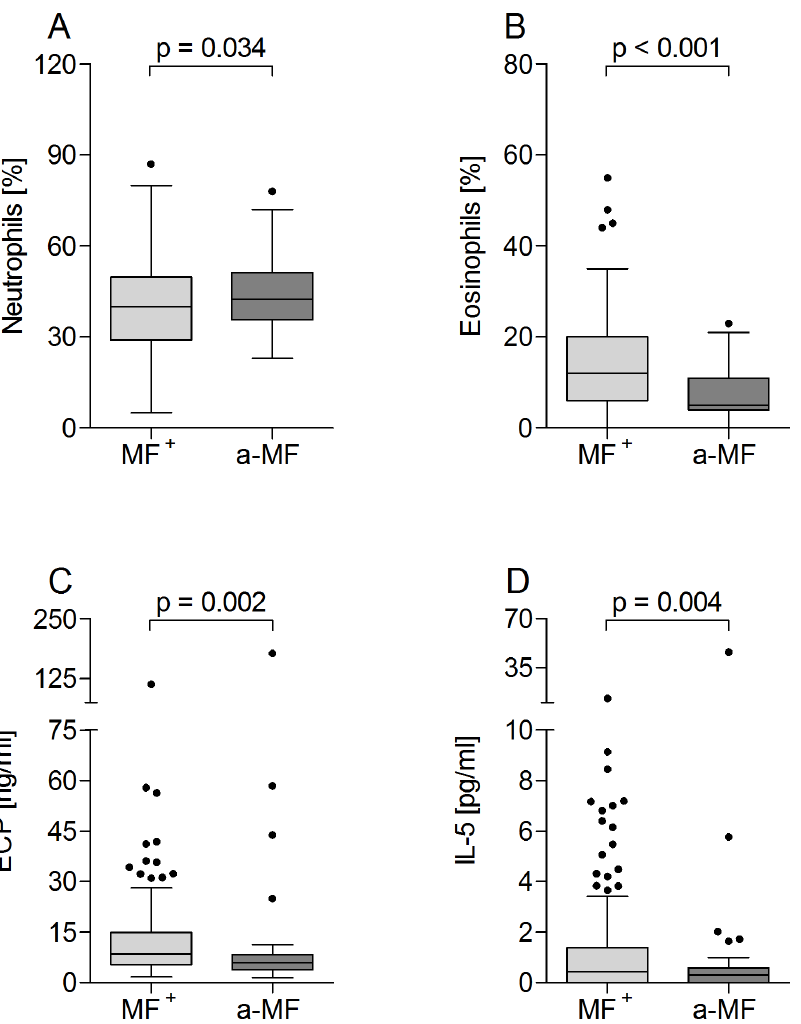
Figure 3. Decreased levels of eosinophils and eosinophil-associated proteins in a-MF patients. O. volvulus infected participants were investigated for the percentages of neutrophils (A) and eosinophils (B) using standard Giemsa stained blood smears. In addition, the presence of ECP (C) and IL-5 (D) were determined in plasma samples by ELISA. Graphs show box whiskers with median, interquartile ranges and outliers. Statistical significances between the indicated groups were obtained after Mann-Whitney